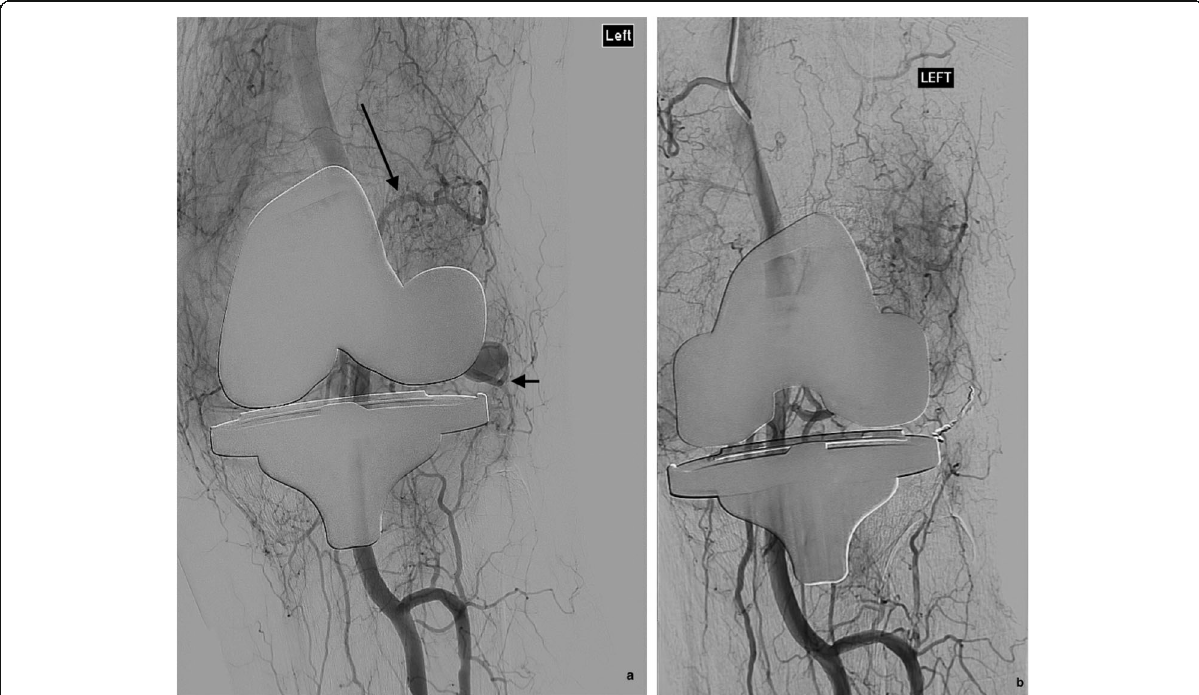
Fig. 2 a Angiography demonstrates abnormally increased vascularity about the total knee replacement prothesis and a hypertrophic and tortuous superior lateral geniculate artery (long arrow). There is a pseudoaneurysm at the anterior aspect of the knee joint arising from the inferior lateral geniculate artery (short arrow). b There is successful occlusion of the pseudoaneurysm following coil embolization (2 x Ruby coils, 3 mm × 5 cm and 4 mm × 6 cm) of the feeding